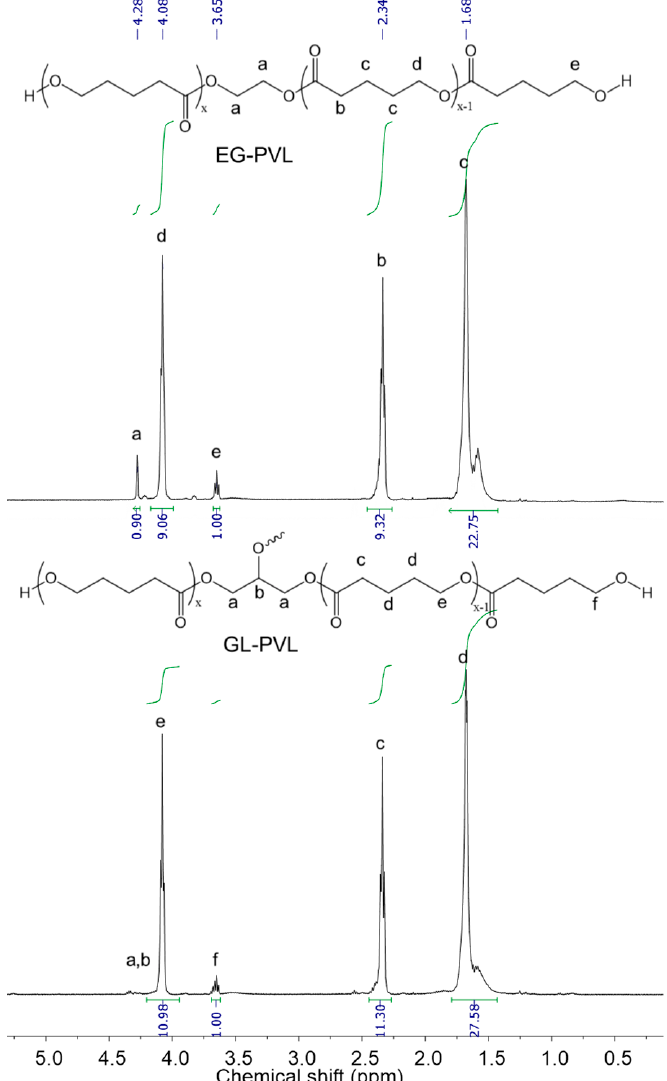
Figure 7. 1 H NMR spectra (400 MHz, CDCl 3 ) of the EG-PVL (top) and GL-PVL (bottom) produced